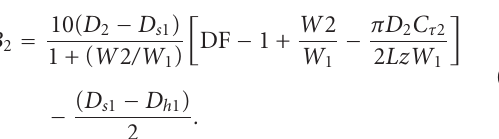
Figure 13: Compressor e ffi ciency change versus clearance.